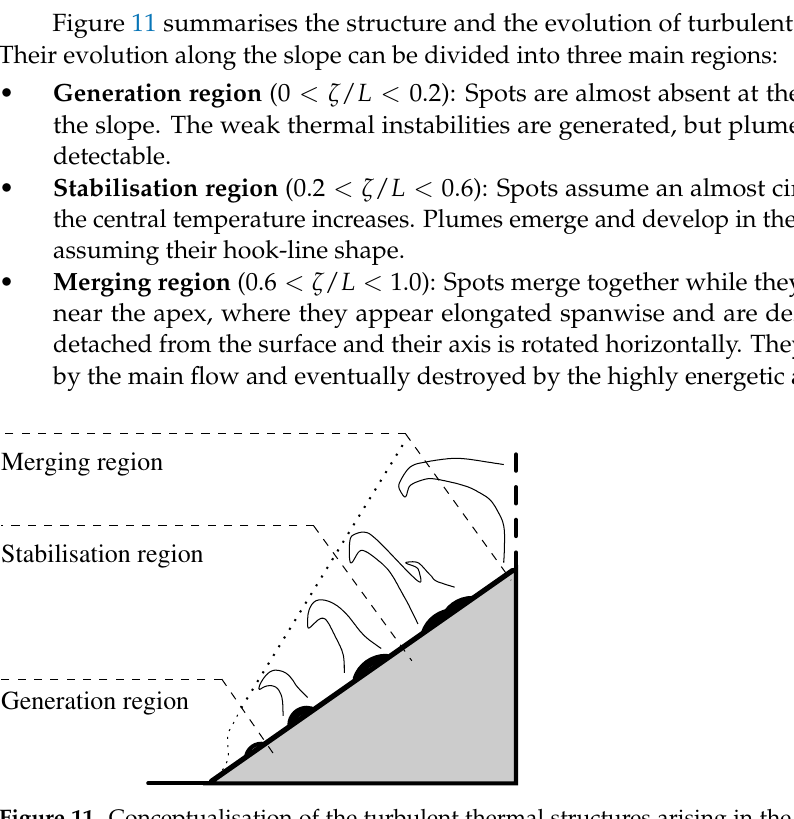
Figure 11. Conceptualisation of the turbulent thermal structures arising in the anabatic flow and their evolution along the